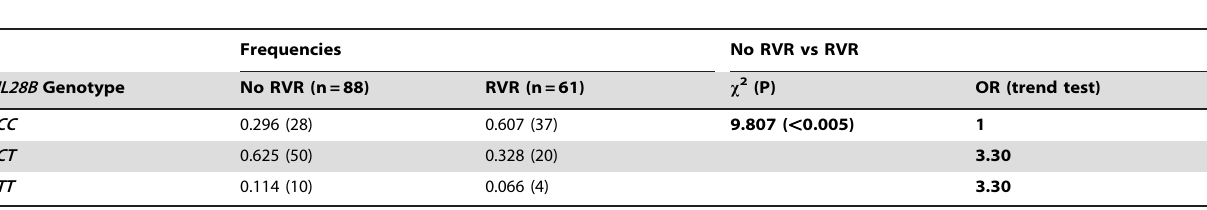
Table 5. The IL28B SNP, rs12979860, is associated with RVR in a cohort of HCV/HIV-1 co-infected